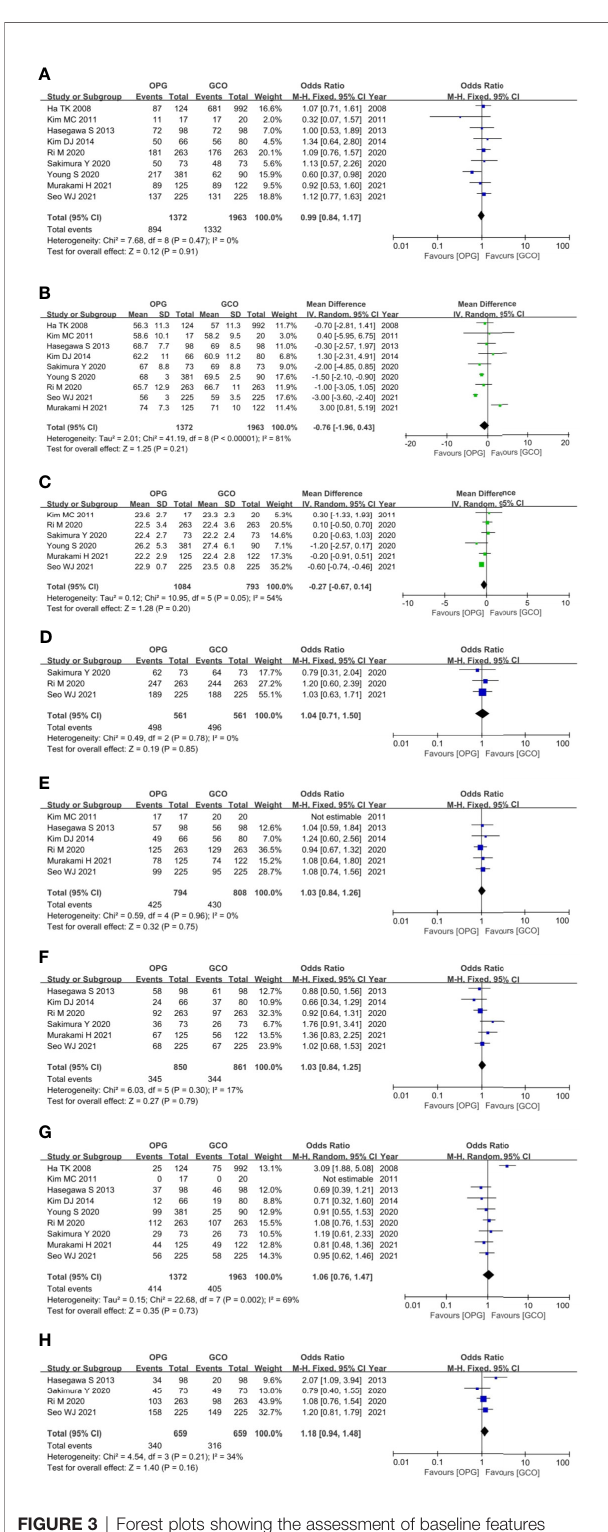
FIGURE 3 | Forest plots showing the assessment of baseline features including (A) sex, (B) age, (C) body mass index, (D) American Society of Anesthesiologists score, (E) pathological stage, (F) histologic type, (G) resected type and (H) adjuvant chemotherapy. OPG, omentum-preserving gastrectomy; GCO, gastrectomy with complete